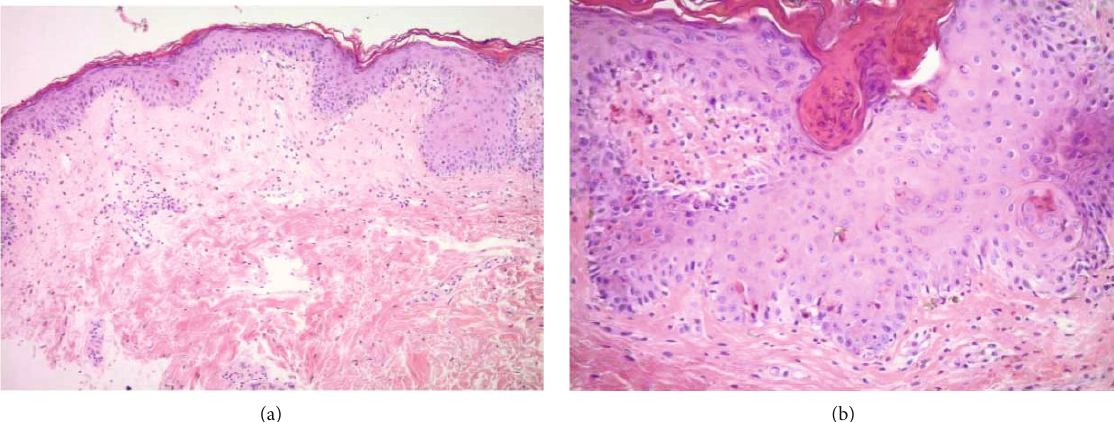
Figure 3: (a) Punch biopsy showing paucicellular lymphocytic in fi ltrate within the dermis (hematoxylin-eosin, original magni fi cation ×